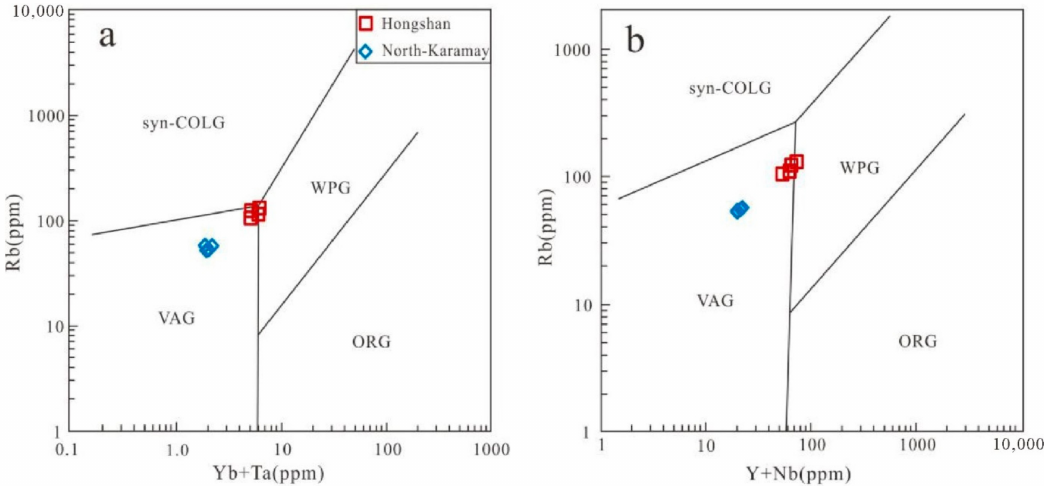
Figure 14. Tectonic discrimination diagramwith trace elemental plots of the studied granitoids: ( a ) Rb vs. (Yb + Ta) (Pearce et al. [112]), and ( b ) Rb vs. (Y + Nb) (Pearce et al. [112]), tectonic discrimination